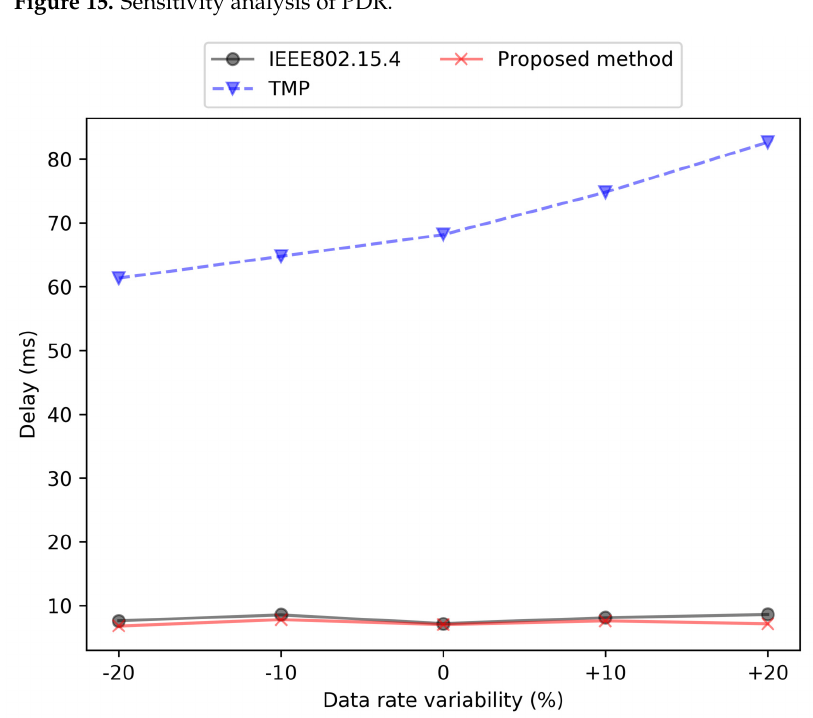
Figure 16. Sensitivity analysis of